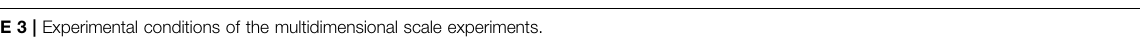
TABLE 3 | Experimental conditions of the multidimensional scale